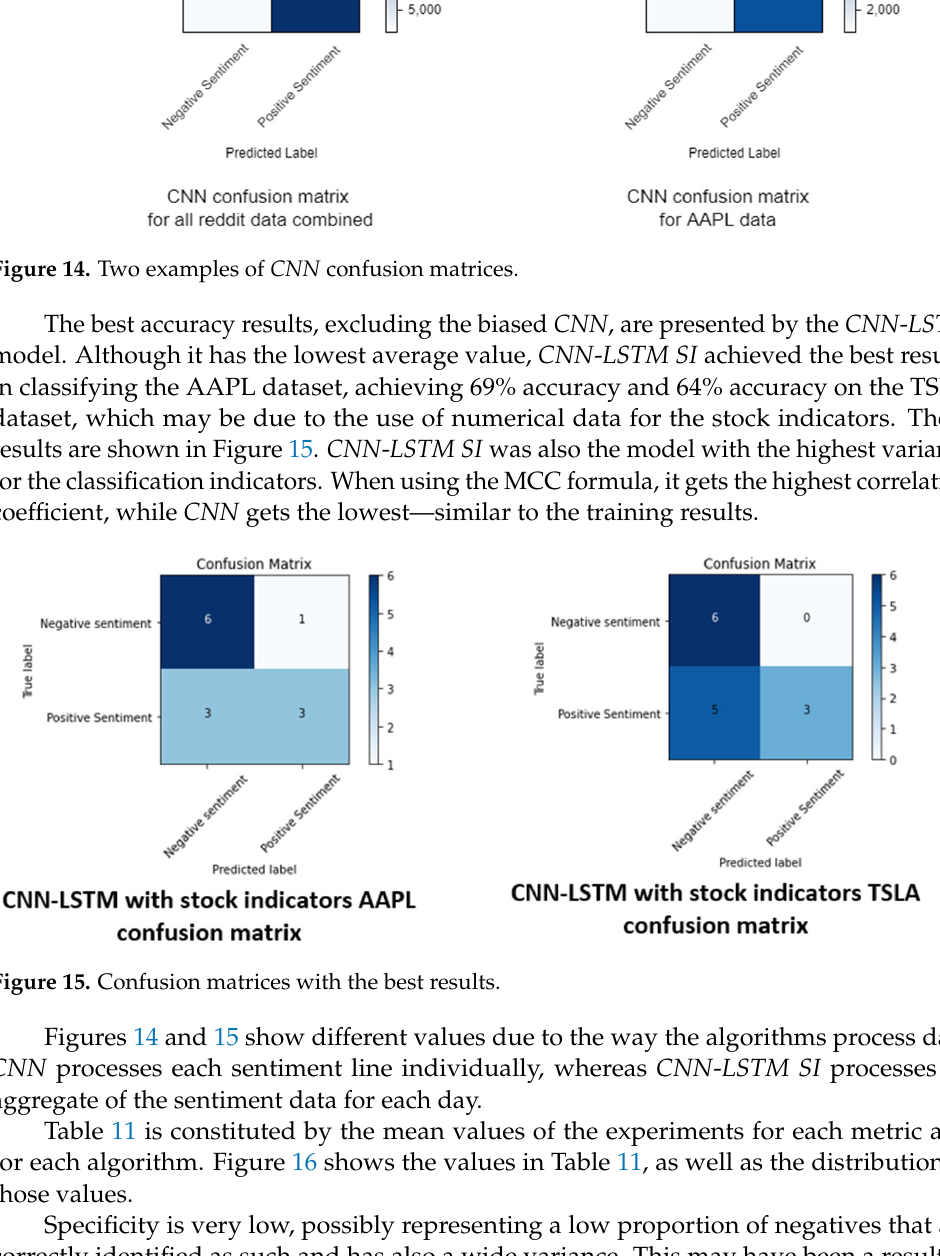
Figure 16. Test indicator